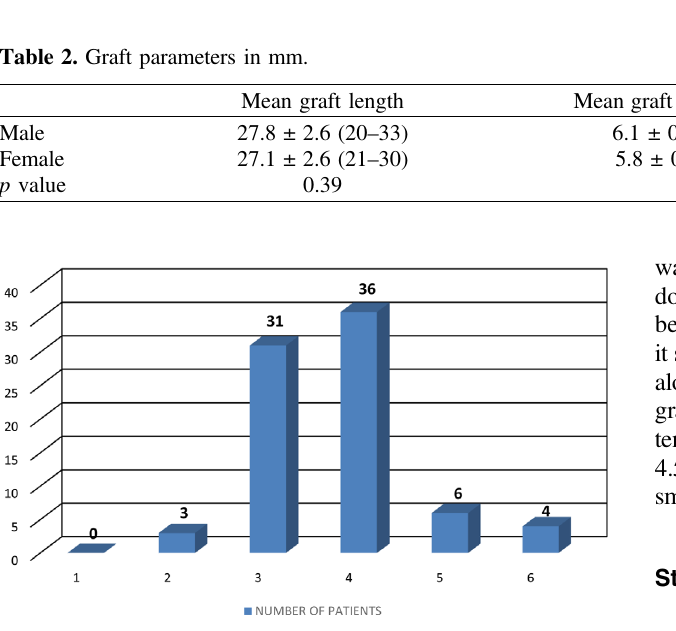
Figure 1. Distribution of Tegner activity scale.